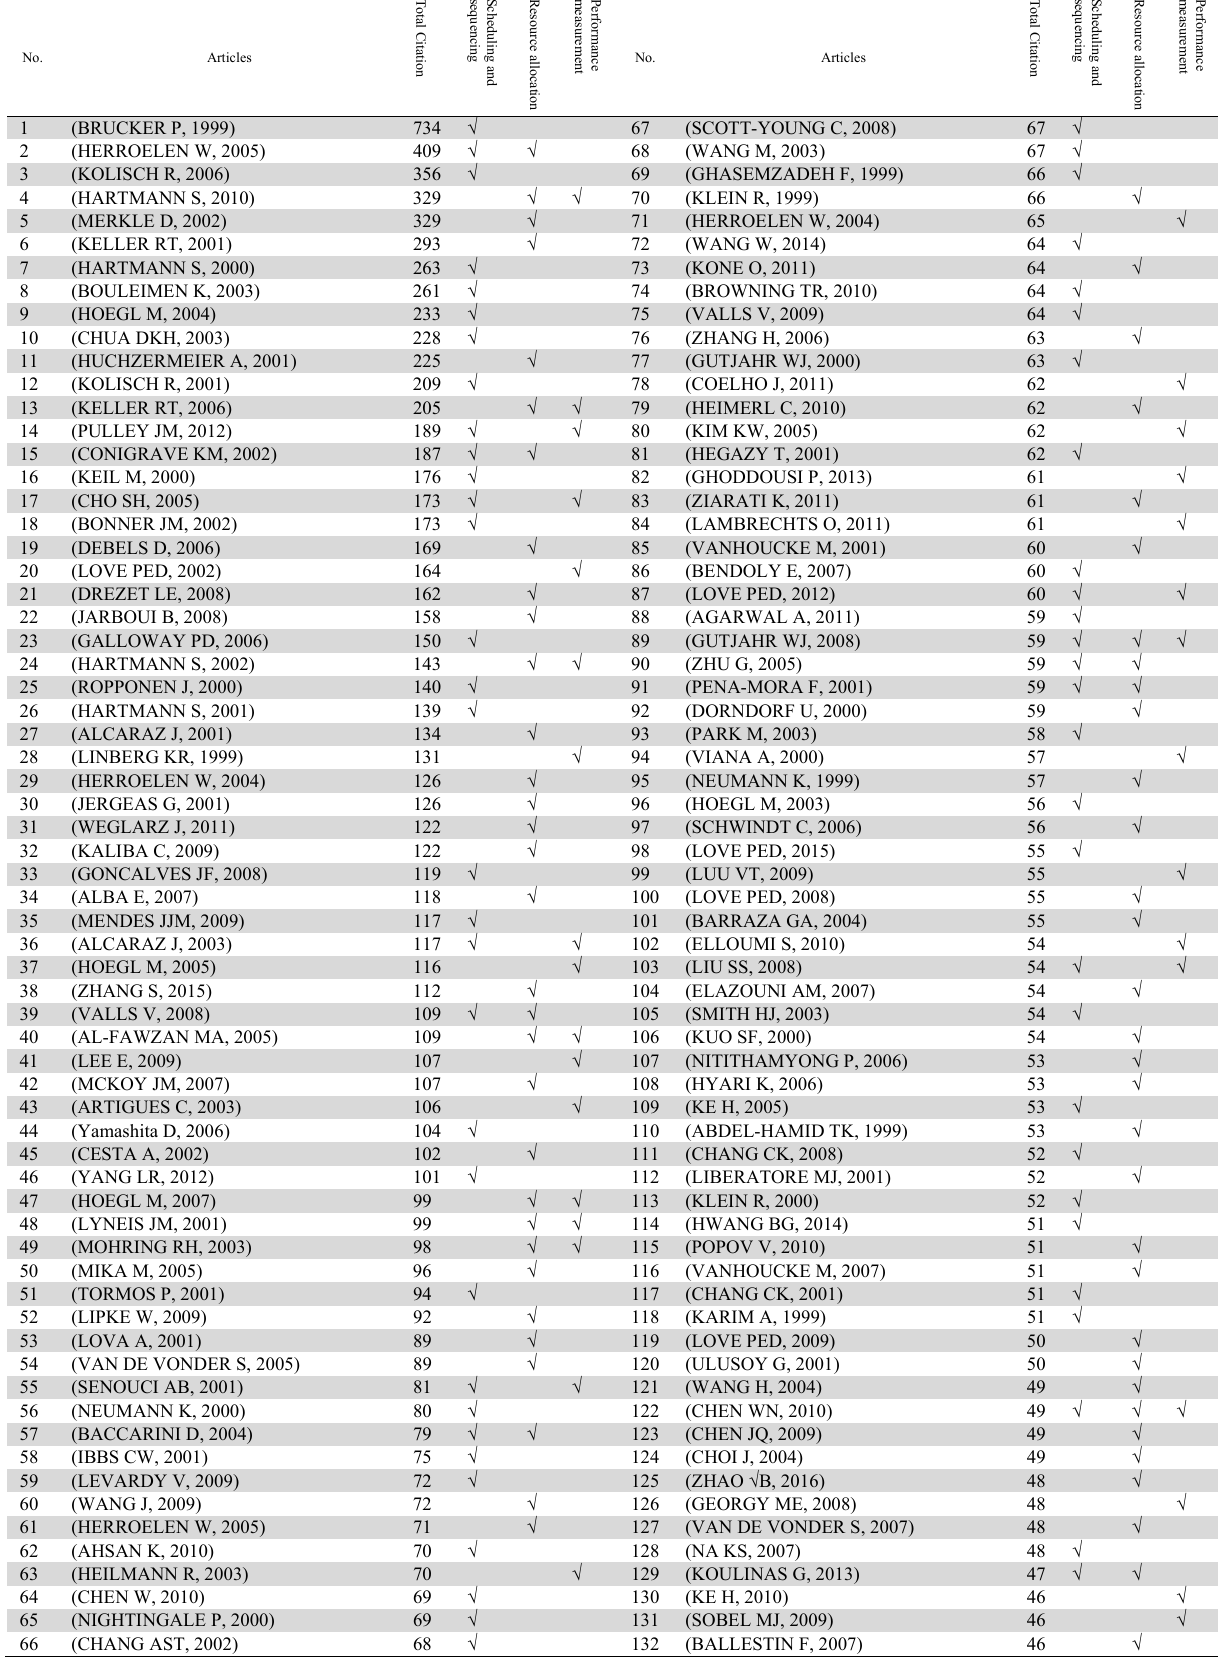
Total citation of each